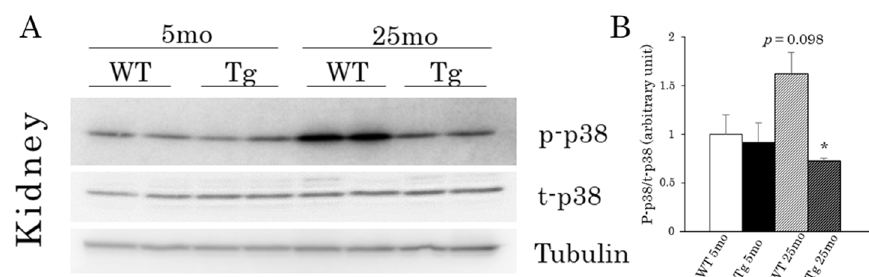
Figure 6. p38MAPK phosphorylation in kidneys of aP2-CREG1-Tg mice. ( A ) Western blotting of phosphorylated p38MAPK (p-p38), total-p38MAPK (t-p38) and tubulin. Tubulin was used as a loading control. ( B ) Relative phosphorylation level of p38MAPK in A; the phosphorylated level was normalized to total-p38MAPK. Data are means ± SEM ( n = 4–5). * p < 0.05 vs. WT at 25 months.